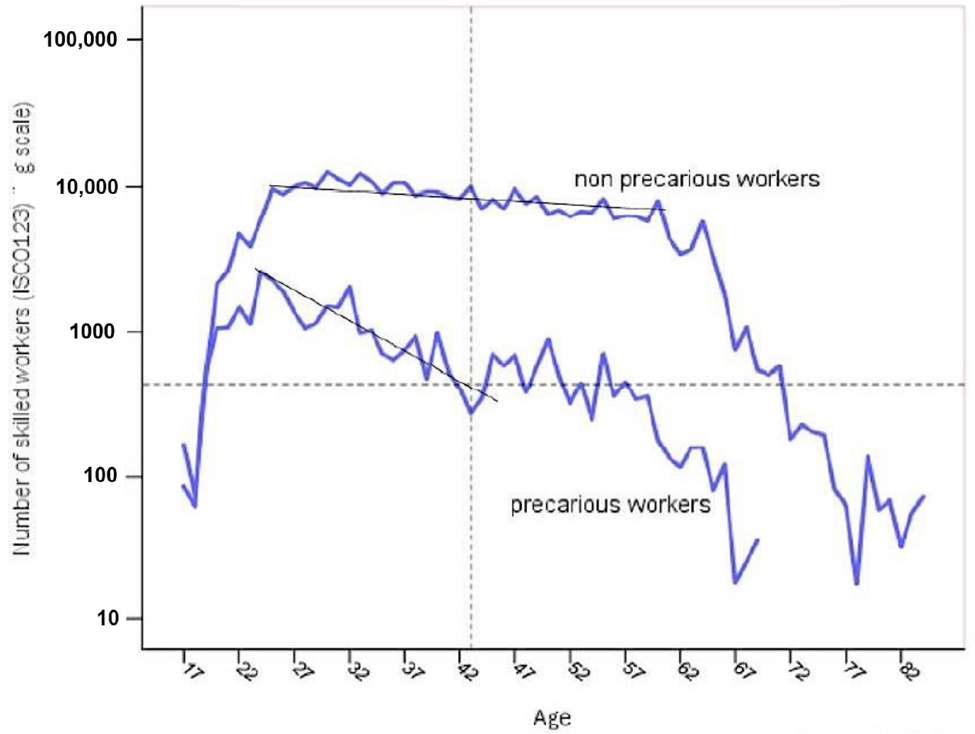
Figure 7. Number of skilled workers (ISCO 1, 2, 3) by age (log scale 2019). Data source: EU-SILC Eurostat (2020).